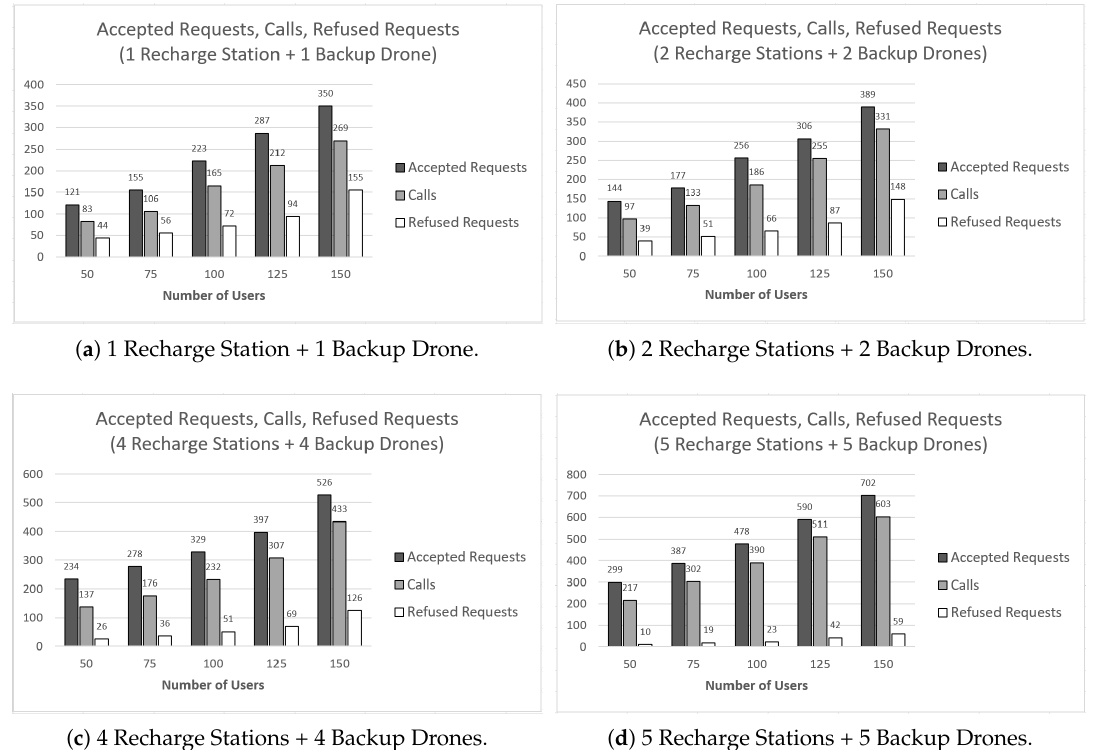
Figure 14. Accepted requests, calls, and refused requests varying users and the recharge stations’ number considering backup